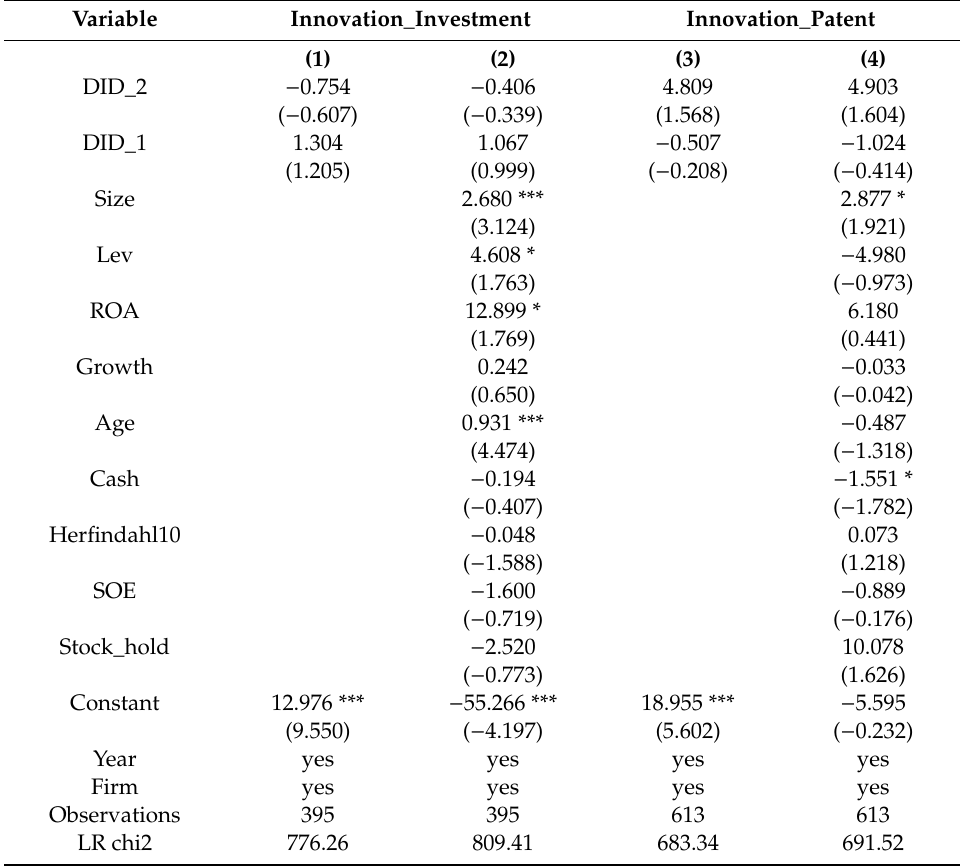
Table 3. Parallel trend hypothesis testing